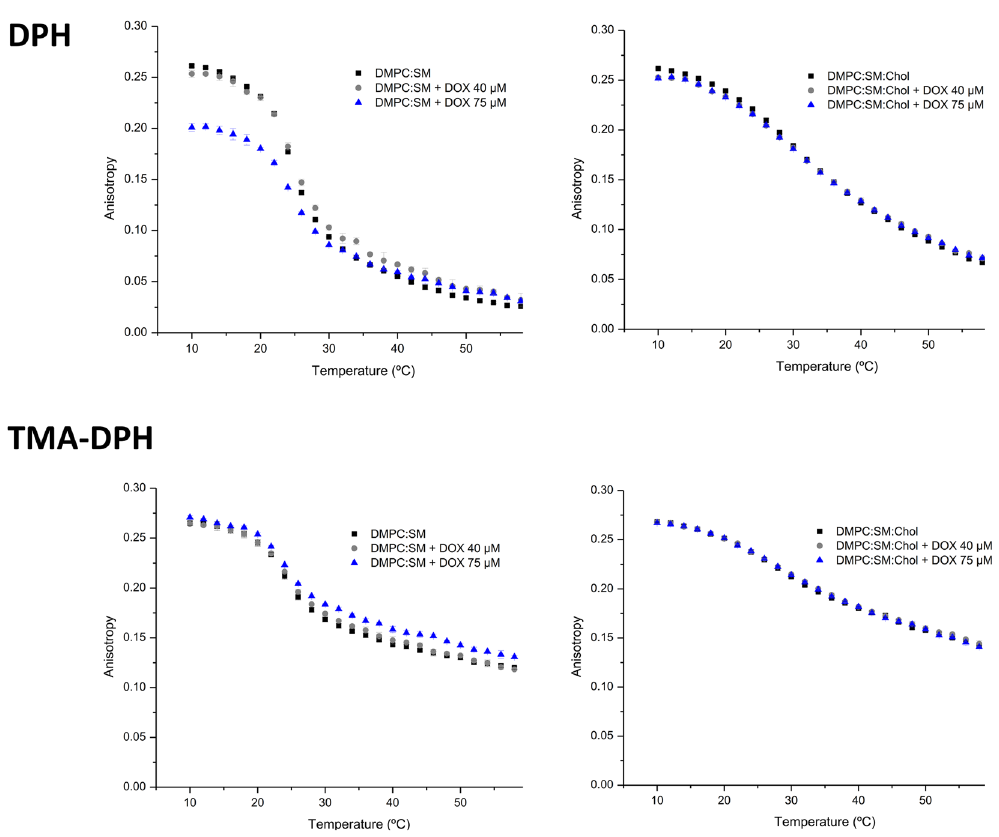
Figure 5. Steady-state anisotropy of DPH and TMA-DPH as a function of temperature in each mimetic model, in the absence ( ◾ ), and in the presence of doxorubicin 40 µ M ( ) and 75 µ M ( ). Results present the mean of at least three independent